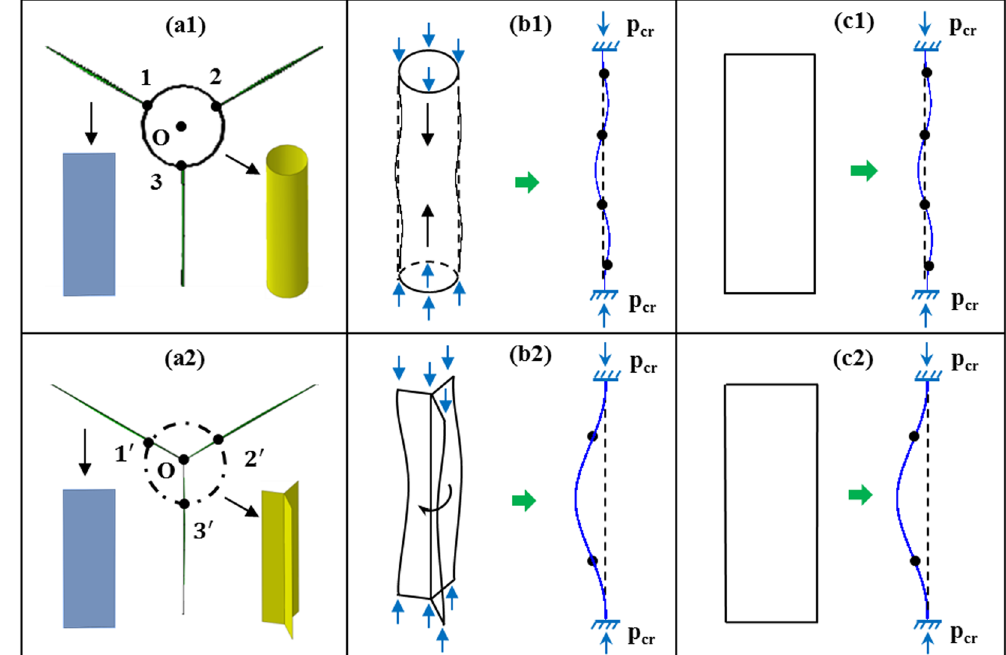
Figure 6. The deformation of the core structure of the sandwich plates. Upper row: BEP; lower row: HP. ( a ) The subdivision of the basic unit. ( b ) The column structure at the intersection of the honeycomb walls. ( c ) The honeycomb wall. The black point are the inflection